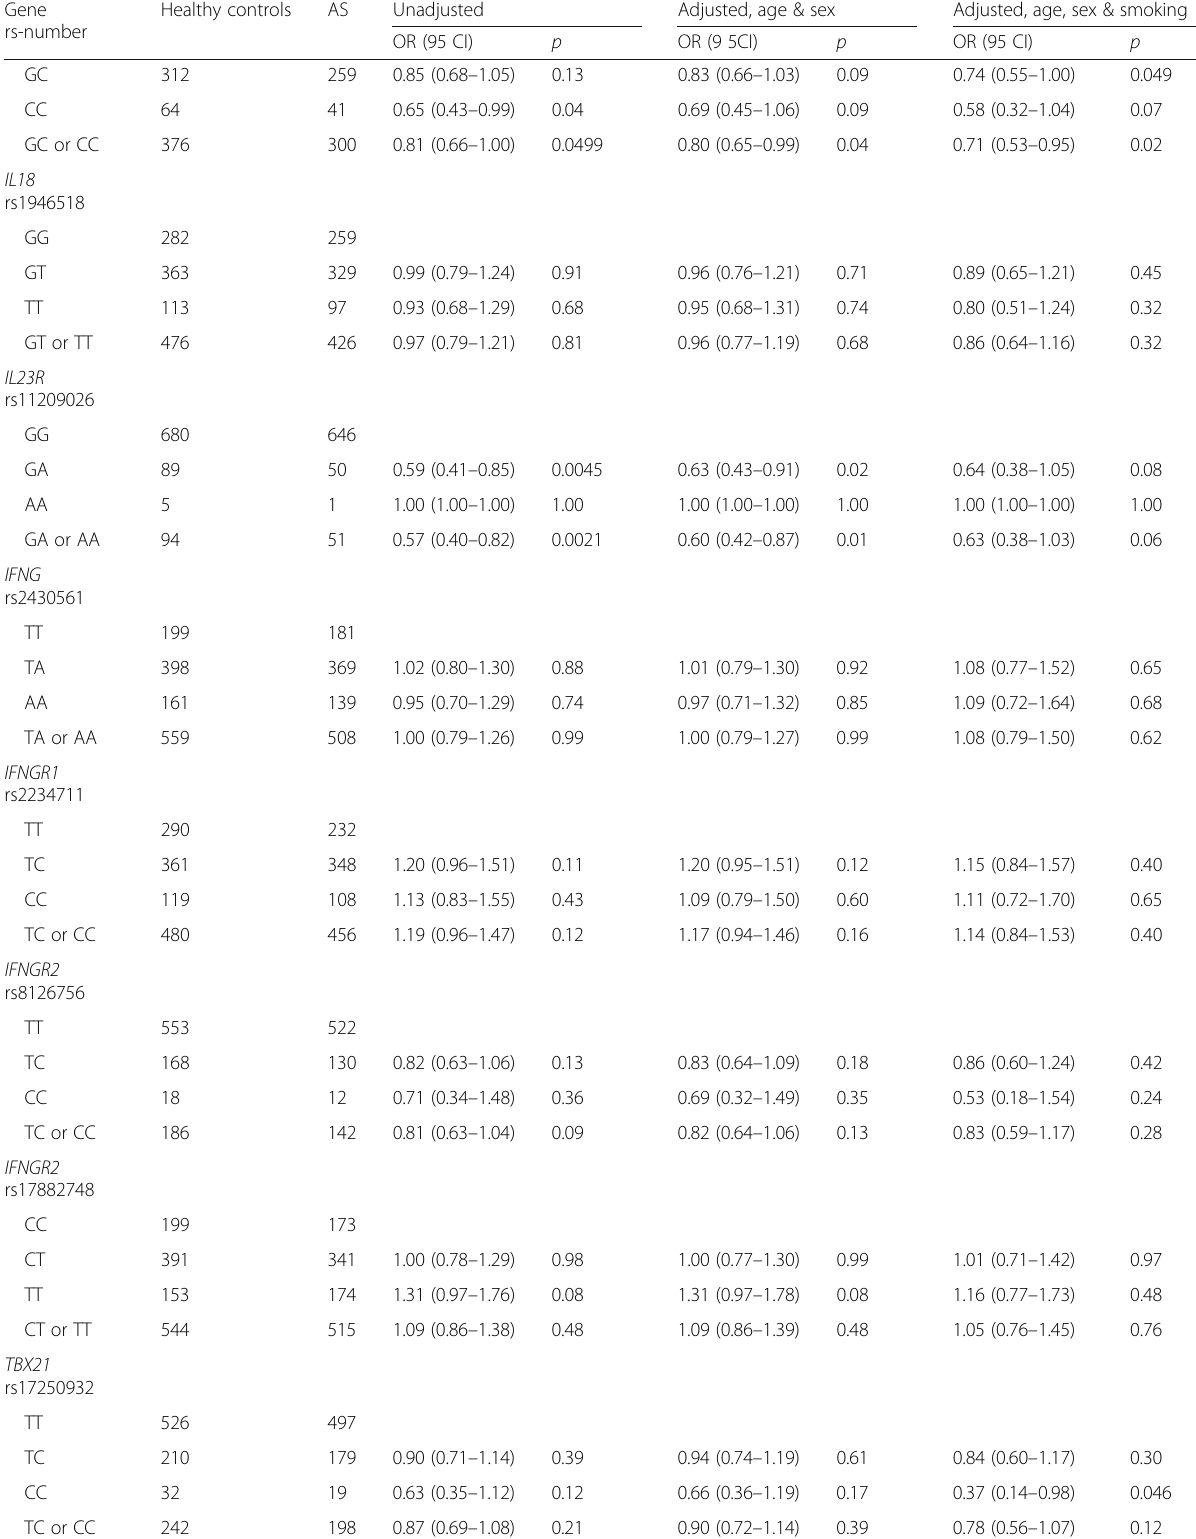
Table 1 Odds ratios (OR) and 95% confidence interval (95CI) for genotypes studied among healthy controls and patients with ankylosing spondylitis (AS)